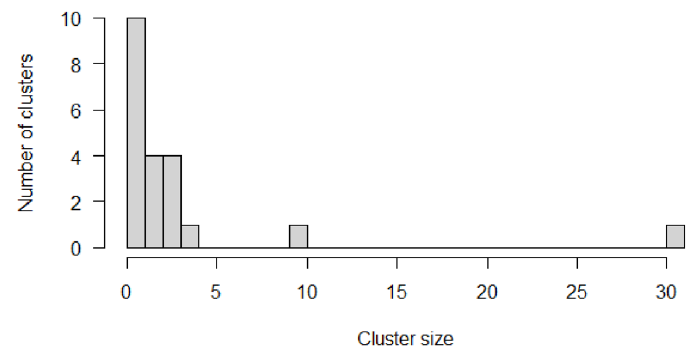
Figure 2. Cluster size distribution of the simulated